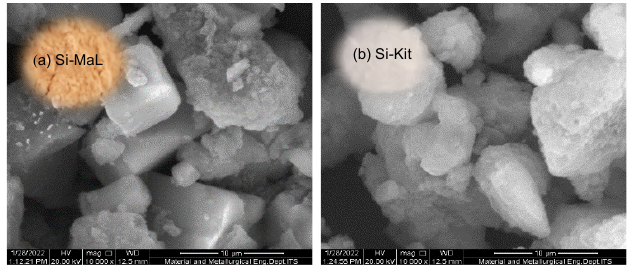
Fig. 2. (a) Si-MaL and (b) Si-Kit adsorbent morphology